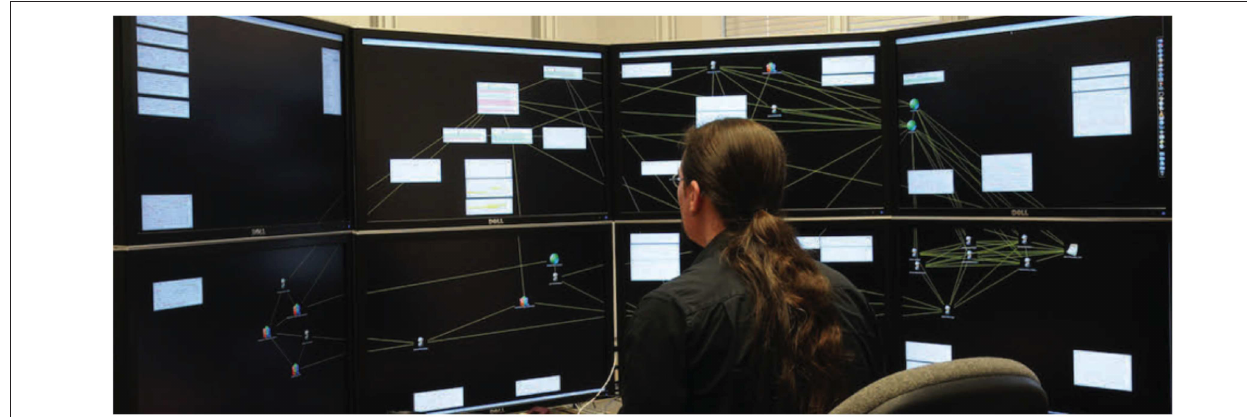
FIGURE 5 | “Space to think” on a large 2D display (Andrews and North, 2012).